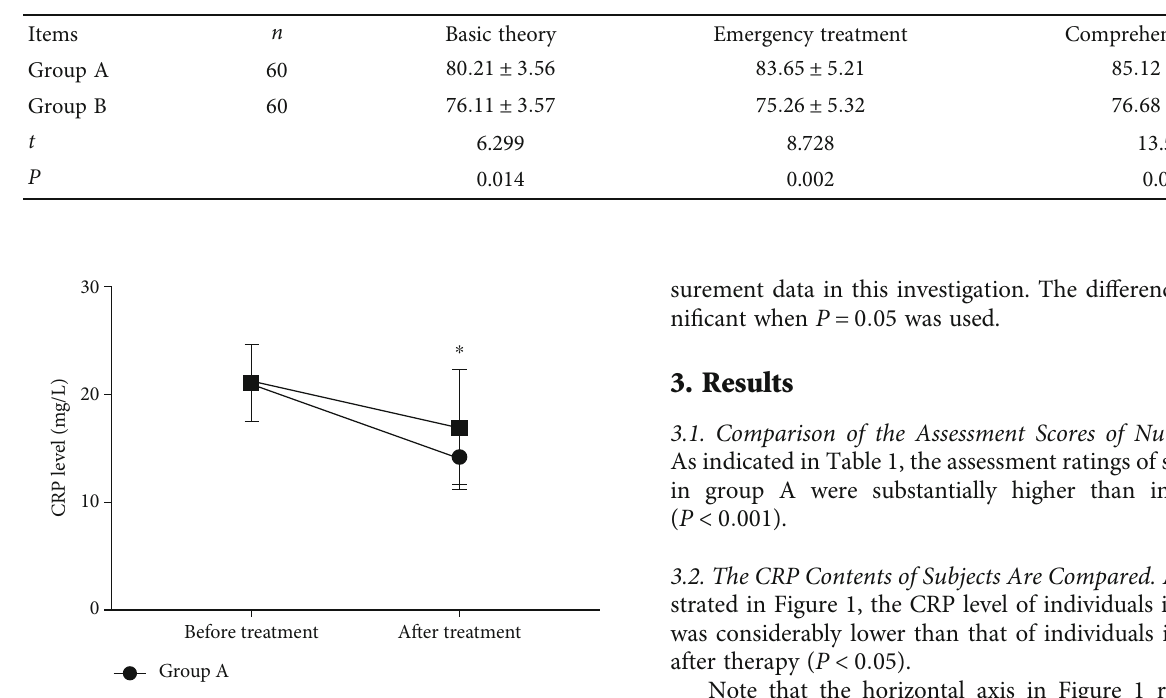
Table 1: Nursing sta ff assessment ratings are compared ( − x ± s , points).